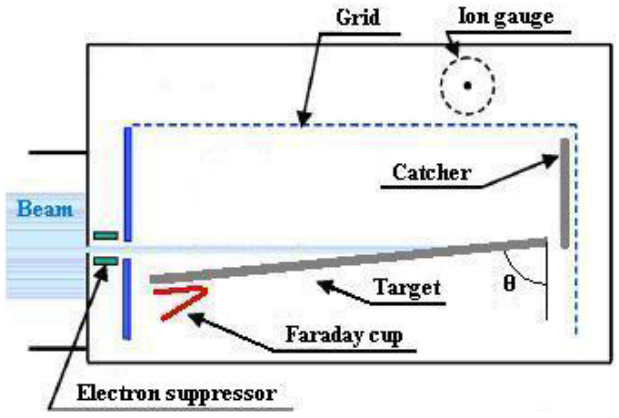
STS-500.FIG. 3. (Color) Gas-electron source diagnostic